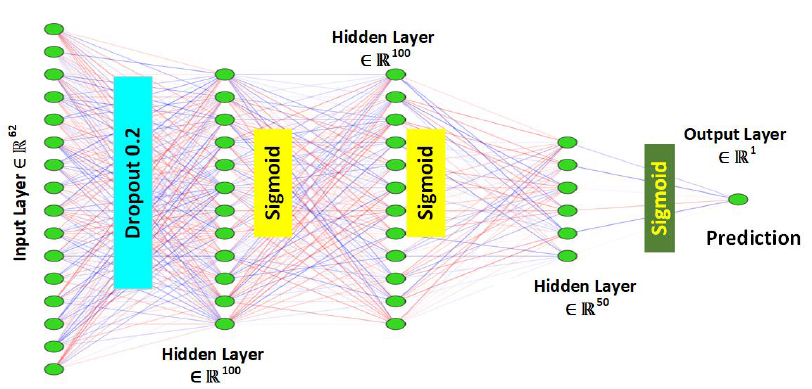
Figure 2. The Proposed Deep Neural Network